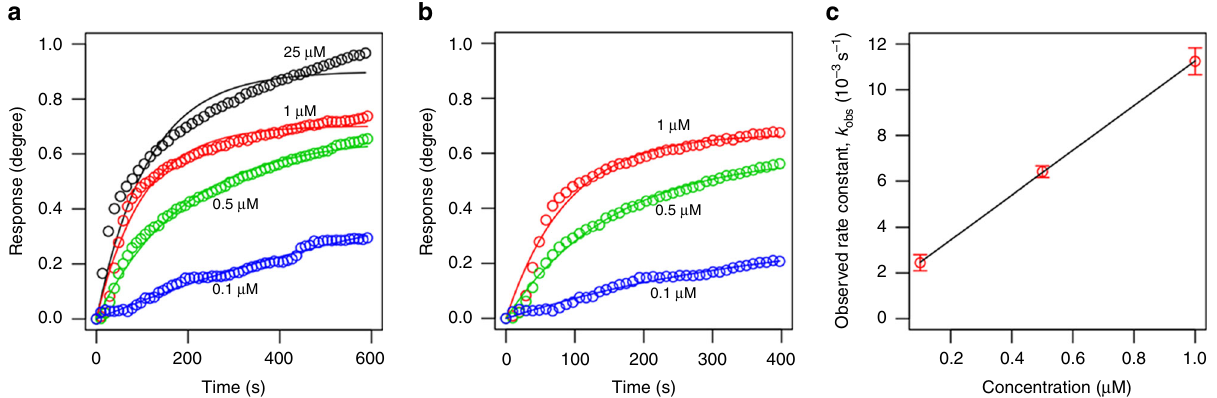
Fig. 4 Fitting of the multi-parametric surface plasmon resonance (MP-SPR) experimental data using the Langmuir model. a Kinetic pro fi les obtained by MP-SPR at four different concentrations, fi tted in the full range 600 s. The experimental data is denoted by the circles and the solid lines are the respective fi tting curves. b The initial 400 s data at low concentrations used to extract kinetic rate constants. c Observed rate constants ( k the peptide concentration. Linear regression was used to calculate the adsorption ( k a ) and desorption ( k d ) rates.